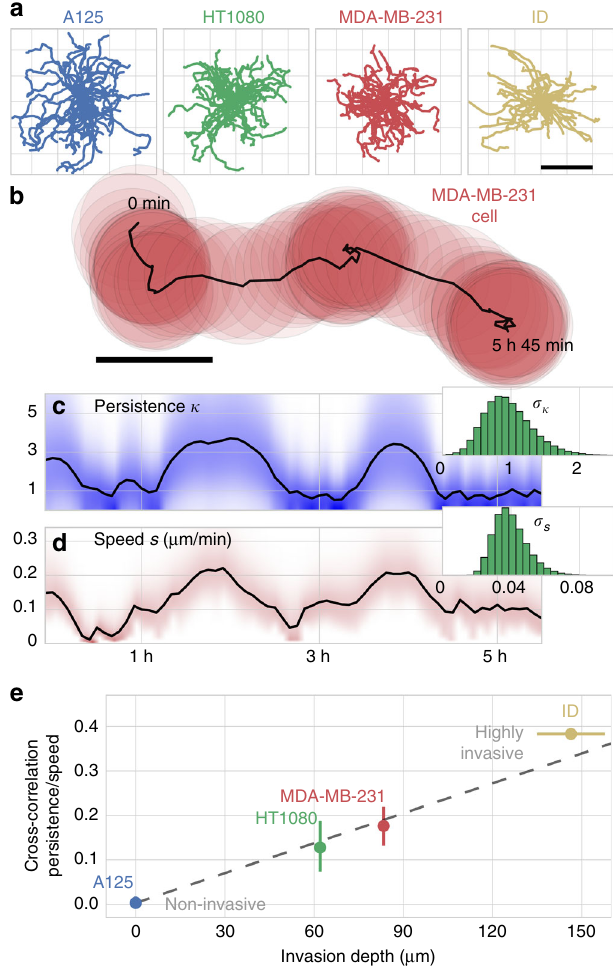
Fig. 3 Heterogeneity in tumor cell migration. a Migration paths of 50 trajectories per cell line over the course of fi ve hours (scale bar = 50 μ m). b Migration trajectory of an MDA-MB-231 cell on a fi bronectin-coated plastic surface. The red circles indicate the nucleus size of the cell (scale bar: 10 μ m). c Inferred mean values (black line) and distribution (shaded blue) of the time-varying directional persistence of the cell. Inset: High-level parameter distribution of the inferred standard deviation of changes in persistence per time step. d Inferred mean values (black line) and distribution (shaded red) of the time-varying cell speed. Inset: High-level parameter distribution of the inferred standard deviation of changes in cell speed per time step. e Correlation coef fi cient of 2D directional persistence and cell speed versus characteristic 3D invasion depth (after 3 days) of four differently invasive cell lines. The dashed line indicates the best linear fi t of the data. Error bars correspond to 1